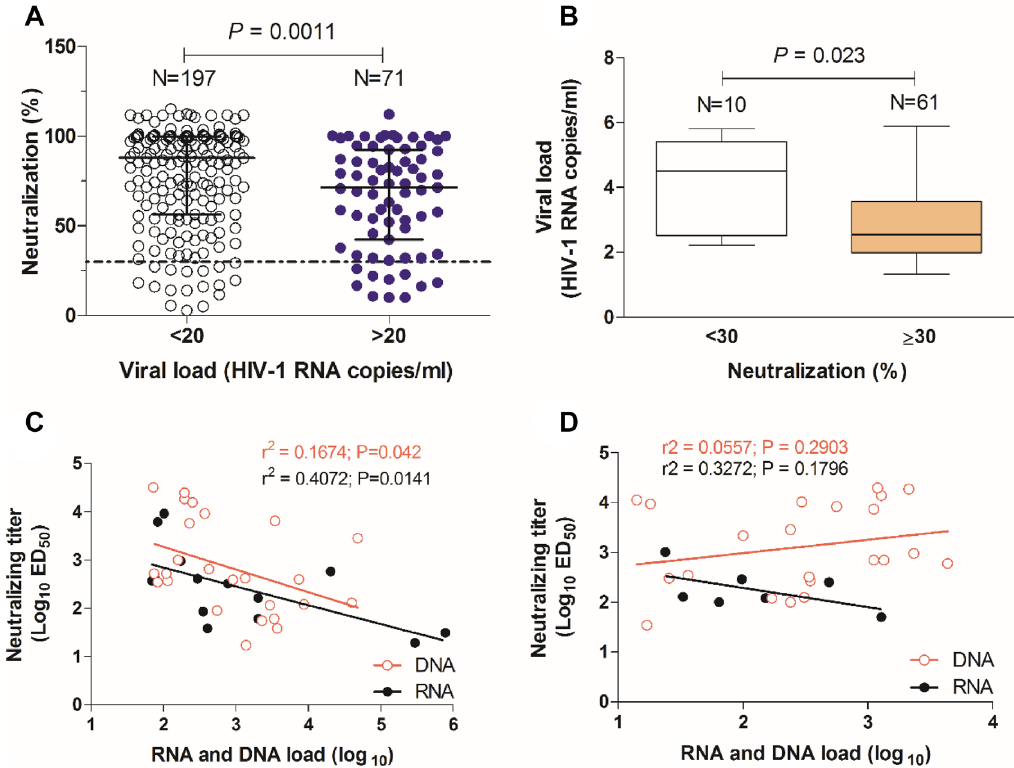
Figure 4. Neutralizing antibody response in relation with viral burden and the presence of 3S or EC26-binding antibodies. ( A ) Percent neutralization of HIV-1 strain NL4-3 (Tier 1a virus) using plasmas from patients with detectable and undetectable viral load. Lines denote the median and interquartile range; ( B ) Box and whiskers plot of viral load in patients with and without neutralizing antibodies. Lines denote median, maximum and minimum values; ( C ) Correlation of neutralizing titers with RNA and DNA load in patients containing 3S-specific antibodies (N = 31); ( D ) Correlation of neutralizing titers with RNA and DNA load in patients containing EC26-specific antibodies (N = 28). The linear regression lines, goodness of fit r 2 and P values are